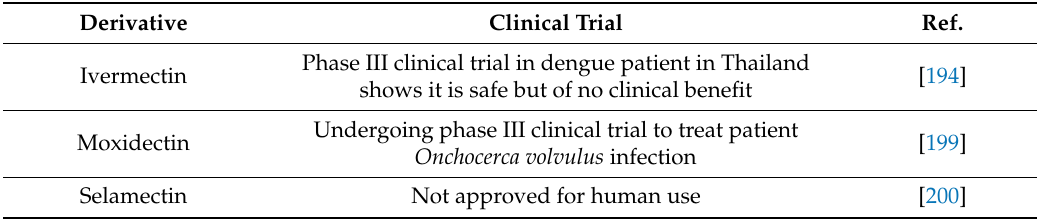
Table 4. Summary of the current clinical trials / human on